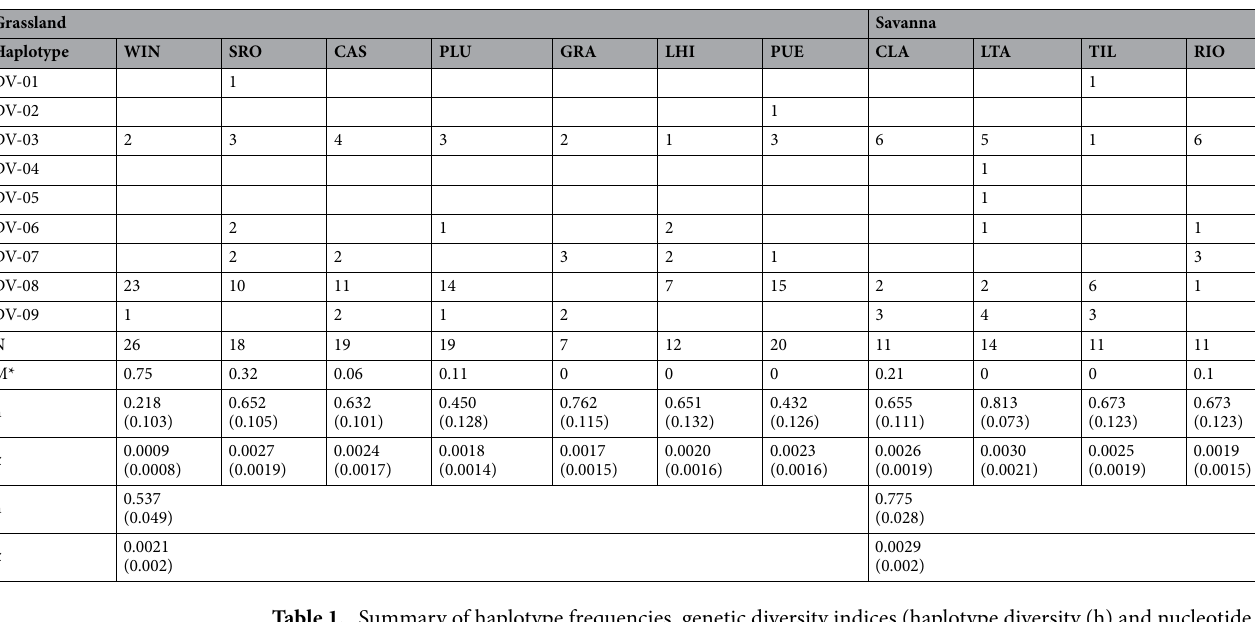
Table 1. Summary of haplotype frequencies, genetic diversity indices (haplotype diversity (h) and nucleotide diversity (π) with their standard deviation) and incidence of fully developed wing morph (M) for 11 population of D. vittatus distributed in two Biomes (Grassland and Savanna). *Data from Rosetti and Remis 41 .